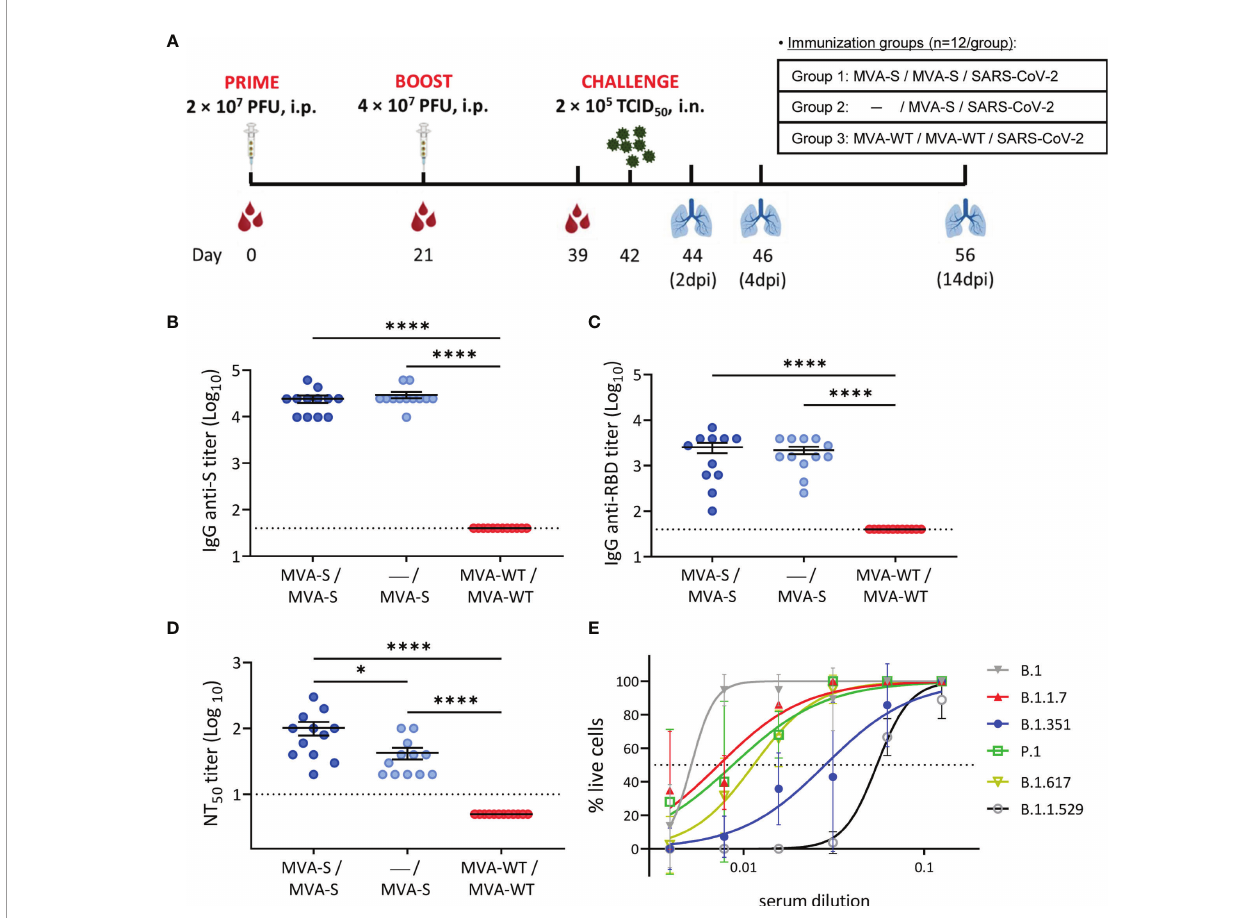
FIGURE 1 | Immunization schedule and analysis of SARS-CoV-2-speci fi c humoral immune responses induced by MVA-S vaccination in hamsters. (A) Experiment overview. Syrian hamsters (n = 12 per group) were immunized by the intraperitoneal (i.p.) route with two doses of MVA-S or MVA-WT at days 0 and 21 or one dose of MVA-S at day 21 and challenged intranasally (i.n.) with 2 × 10 5 TCID 50 (median tissue culture infectious dose) of SARS-CoV-2 B.1 strain at day 42, as indicated. Blood was collected before boosting (day 21 post prime immunization) and before challenging (day 39, 18 days post-boost). On 2, 4, and 14 days post-infection (dpi), 4 animals per group were sacri fi ced and their lungs were collected for virological and histological analysis. (B, C) Titers of anti-S (B) and anti- receptor-binding domain (RBD) (C) binding IgG antibodies determined by ELISA in serum collected on day 39. Mean values and SEM are represented. Dashed line represents the limit of detection. (D) SARS-CoV-2 neutralizing antibody titers. NT 50 (50% neutralization) titers were evaluated in serum collected on day 39 using a live virus microneutralization assay with SARS-CoV-2 MAD6 isolate. Mean NT 50 values ± standard error of the mean (SEM) are represented. (E) SARS-CoV-2 neutralizing antibody titers against SARS-CoV-2 VoC. Pooled serum from hamsters vaccinated twice with MVA-S and obtained at day 39 was used in a cytopathic effect (CPE)-based neutralization assay against different SARS-CoV-2 variants of concern (VoCs). Median inhibitory concentrations (IC 50 , dotted line) per variant were calculated by non-linear curve fi tting of the percentage of live cells. Data presented as means ± SEM. Statistical signi fi cance between groups was calculated by Mann – Whitney test (*p < 0.05, ****p <